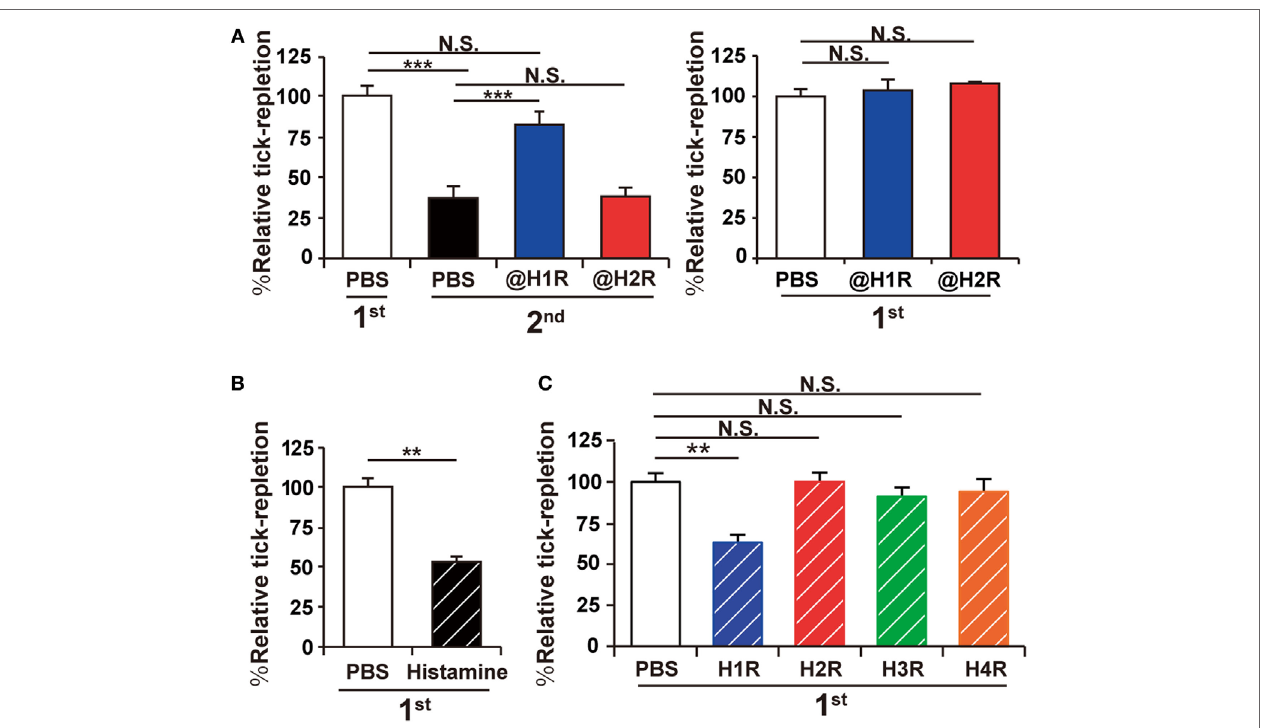
FigUre 1 | Acquired tick resistance is abrogated by a histamine H1 receptor antagonist. (a) Mice were infested with tick larvae once (right panel) or twice (left panel). They were treated with intravenous administration of histamine H1 or H2 receptor antagonist (@H1R or @H2R) or control PBS once a day for 7 days, starting 1 day before the first infestation (left panel) or the second infestation (right panel). The relative tick repletion in each experimental group is shown (mean ± SEM, n = 3 each), in that the value in the first infestation of mice treated with control PBS was defined as 100%. (B,c) Mice were infested once with tick larvae. Histamine (B) , histamine receptor (H1R, H2R, H3R or H4R) agonists (c) , or control PBS was injected intradermally beneath the tick-infested site once a day for 7 days, starting 1 day before the infestation. The relative tick repletion was calculated and shown as in (a) (mean ± SEM, n = 3–4). All the data shown are representative of three independent experiments. Statistics: t- test in (B) and one-way ANOVA in (a) and (c) N.S., not significant; ** p < 0.01; *** p <